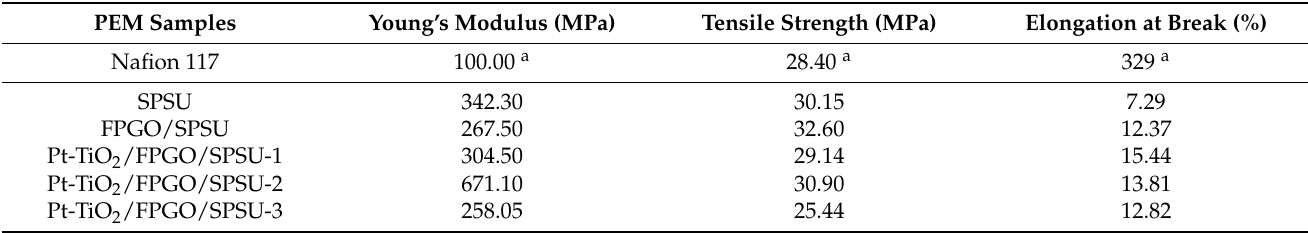
Table 1. Mechanical properties of all the